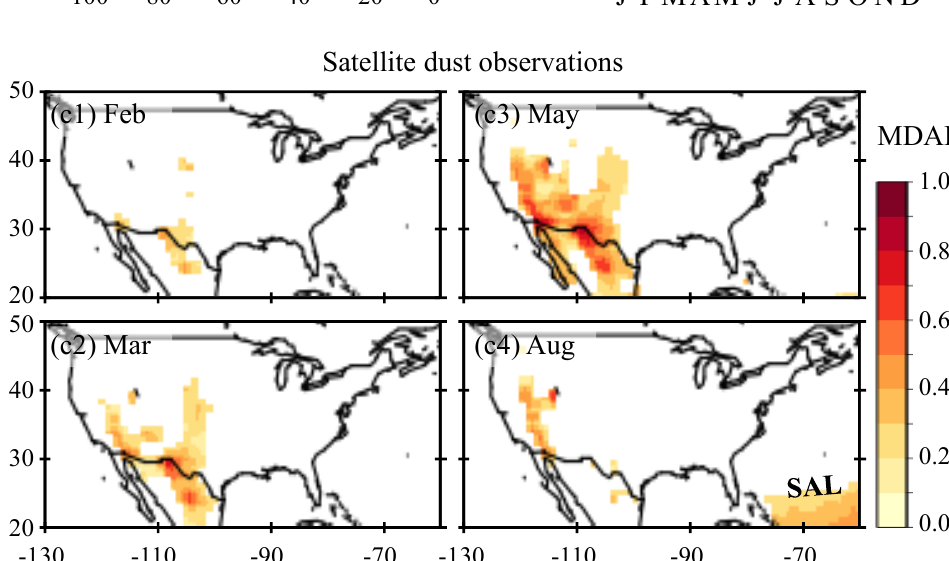
Figure 8. (a) Median Concentration At Receptor (MCAR) plots and (b) monthly median distribution for calcium (Ca), aluminium (Al) and dust, and (c) major dust activity frequency (MDAF) for the study period: the number of days with AI values > 1 divided by the total number of days with available AI data in % (data source: http://disc.sci.gsfc.nasa.gov/). The maximum concentration tick label of the MCAR plots includes concentration higher than this upper limit. The location of Izaña is highlighted (black